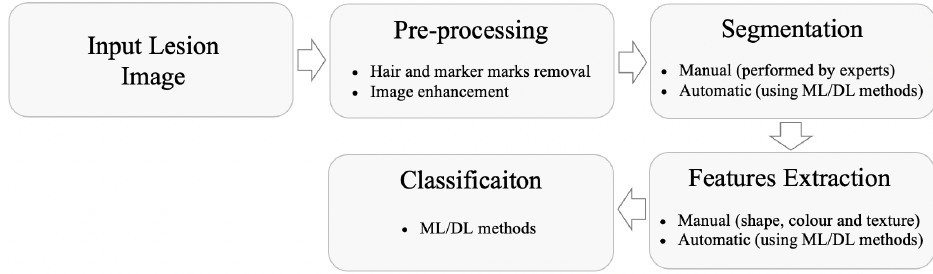
Figure 2. CAD’s pipeline for skin lesion image